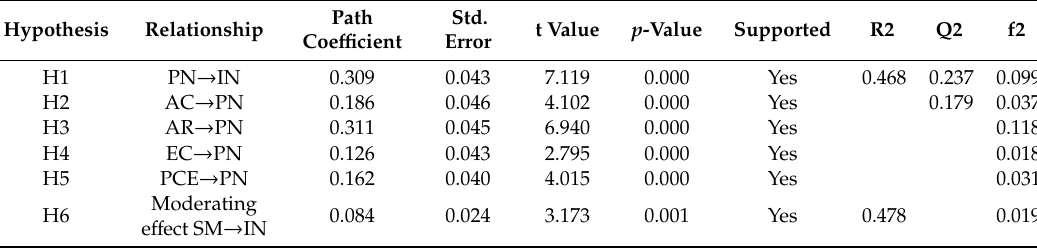
Table 4. Structural model results (hypotheses